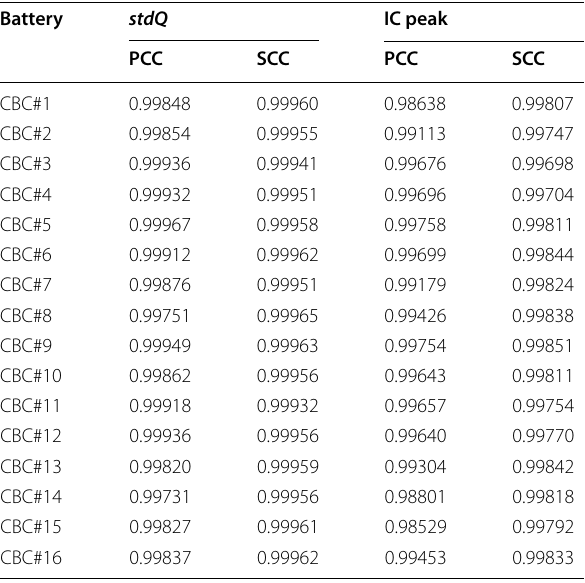
Table A2 Numerical results of the correlation coefficients for